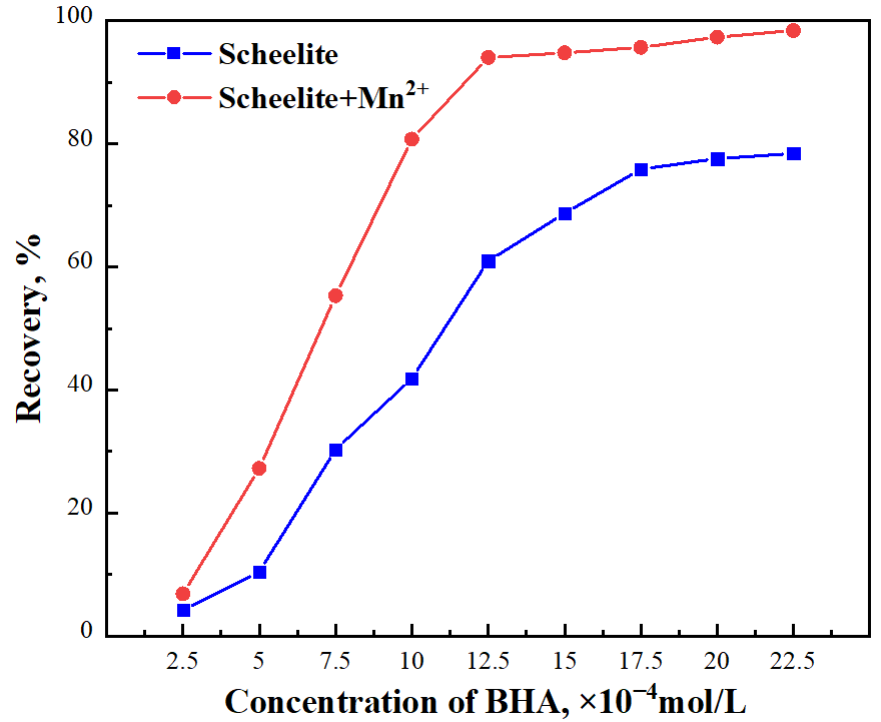
Figure 4. Effect of BHA concentration on the recovery of scheelite flotation.